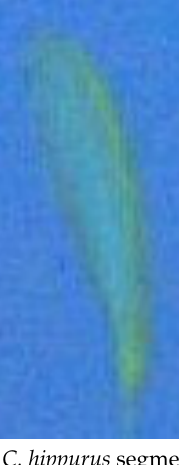
Figure 9. ( a ) An image captured in the Deep Themo deployment with one Coryphaena hippurus . ( b ) Segment of the fish extracted from the